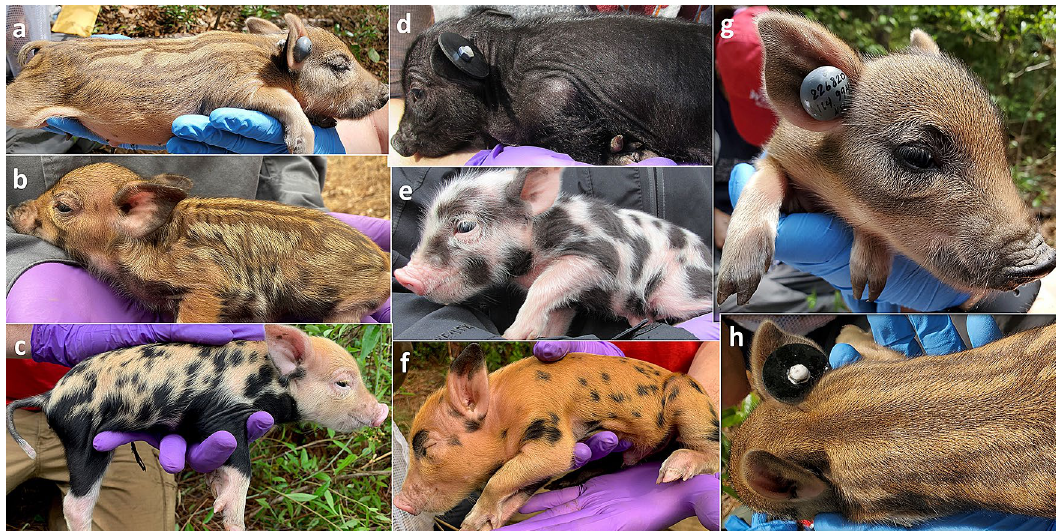
Figure 1. Variation in pelage coloration of wild pig neonates ( a – f ) and VHF transmitter ear tag ( g – h ). Phenotypic variation in pelage coloration of wild pig ( Sus scrofa ) neonates and VHF transmitter ear tag (Model RI-2BMH; Holohil Systems Ltd.) designed for tracking real-time survival of neonate wild pigs on the Savannah River Site, Aiken, Allendale, and Barnwell counties, South Carolina, USA. ( a ) Wild type, brown striped, ( b ) wild type, brown striped and spotted, ( c ) tri-colored (white, brown and black) spotted, ( d ) solid black, ( e ) black and white spotted, ( f ) red/brown and spotted, ( g ) front view of ear tag ( h ) back view of ear Adult female capture and VIT deployment. All capture and handling of animals was conducted in compliance under approved protocol by the Institutional Animal Care and Use Committee under the Univer- sity of Georgia (A2015 05-004; A2018 06-024) and the ARRIVE guidelines for the immobilization of animals for studies conducted in the field. From September 2017 to February 2020, we captured adult female wild pigs in corral traps baited with whole corn. We immobilized animals via dart rifle (X-CALIBER, Pneudart, PA) using a combination of Telazol (4.4 mg kg −1 ; MWI Veterinary Supply, ID) and Xylazine hydrochloride (2.2 mg kg −1 ; Wildlife Pharmaceuticals Inc., CO) in 2017–2018, or with a combination of butorphanol (0.43 mg kg −1 ), azaperone (0.36 mg kg −1 ), and medetomidine (0.14 mg kg −1 ) (BAM, 0.0064 ml kg −1 ; Wildlife Pharmaceuticals Inc., CO) and ketamine hydrochloride (2.2 mg kg −1 ; Wildlife Pharmaceuticals Inc., CO) in 2018–2020. Xyla- zine hydrochloride was antagonized with yohimbine (0.15 mg kg −1 ; MWI Veterinary Supply, ID) and BAM was antagonized with a combination of naltrexone (50 mg ml −1 ; Wildlife Pharmaceuticals Inc., CO) and atipamezole (25 mg ml −1 ; Wildlife Pharmaceuticals Inc., CO), and individuals were monitored until recovery. Upon immobilization, individuals were weighed, measured, and age was determined through examination of molar eruption patterns 47,48 . We assessed whether captured females were pregnant via serial remote camera images at bait stations, palpation, and a portable ultrasound (SeeMore USB, Interson Corporation, CA). Pregnant females were implanted with a 21 g VIT (M3930; Advanced Telemetry Systems, MN) via methods similar to white-tailed deer studies that previously have been employed for wild pigs 31 . Briefly, the VIT was inserted into the vagina and placed against the cervix with the wings oriented laterally within the body. VITs included a thermis- tor that sensed a change in temperature upon expulsion during parturition that signaled the number of 30-min intervals elapsed since the change in temperature. Females with VITs were also collared with a VHF (Model TGW-4501; Telonics Inc., AZ) or GPS collar (Model TWG-4577; Telonics Inc. or Vertex Plus; Vectronic Aero- space, Berlin, Germany) to facilitate tracking. Pregnant sows were monitored 3–7 times/week until parturition. Neonate capture and handling. Because of the potential of abandonment, we waited 22–48 h after par- turition to capture and tag neonates to promote bonding and investment by the sow (e.g., Ref. 34 ). We homed to the VIT signal at the farrowing nest, flushed the female, and captured piglets by hand. Once captured, we placed piglets in mesh bags, and subsequently weighed, photographed, and noted sex and pelage coloration of all indi- viduals at the nest location. Within each litter, we tagged a subset of 1–3 piglets with a custom designed VHF transmitter ear tag (Model RI-2BMH; Holohil Systems Ltd., Ontario, Canada). Previous attempts to affix radio transmitters to neonate wild piglets resulted in poor retention or failure 31 . To address these issues, our modified design consisted of a stud ear tag with a nylon post that was approximately 2 cm in diameter and weighed 5 g. We customized it with an internal, coiled antenna to prevent damage or malfunction of the transmitter and included a mortality sensor that activated after 12 h of inactivity. In the field we further modified the tag by using a metal fastener and a small and large neoprene washer on the front and backside of the ear, respectively, to prevent the tag from pulling out (Fig. 1). After these modifications, the tag weighed ~ 10 g at deployment. Piglets were released simultaneously at the natal nest at the conclusion of processing. We deployed remote infrared motion sensor cameras (PC900 HyperFire Professional Series; Reconyx, WI) at the nest area to capture piglet activity post-tagging, document when the female reunited with her offspring, and when the female and piglets left the